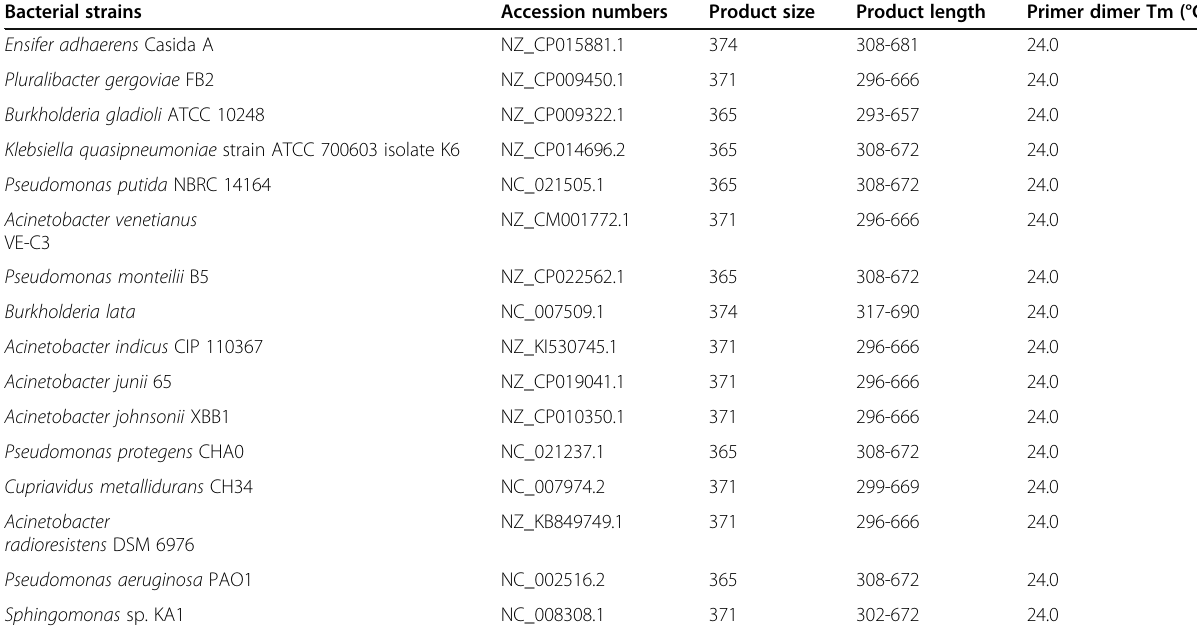
Table 8 In silico PCR analysis of primer pair catAf/catAr with targeted sequences Bacterial strains